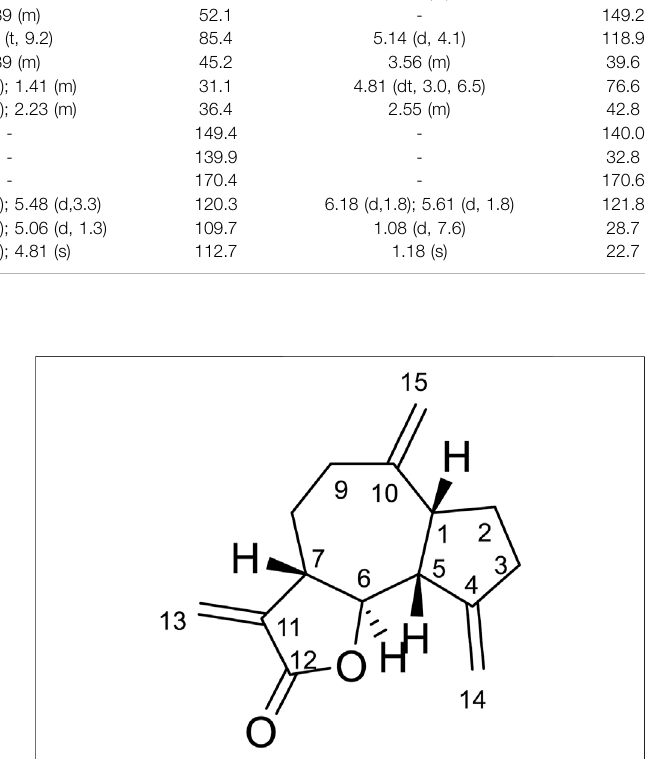
FIGURE 2 | Chemical structural of dehydrocostus